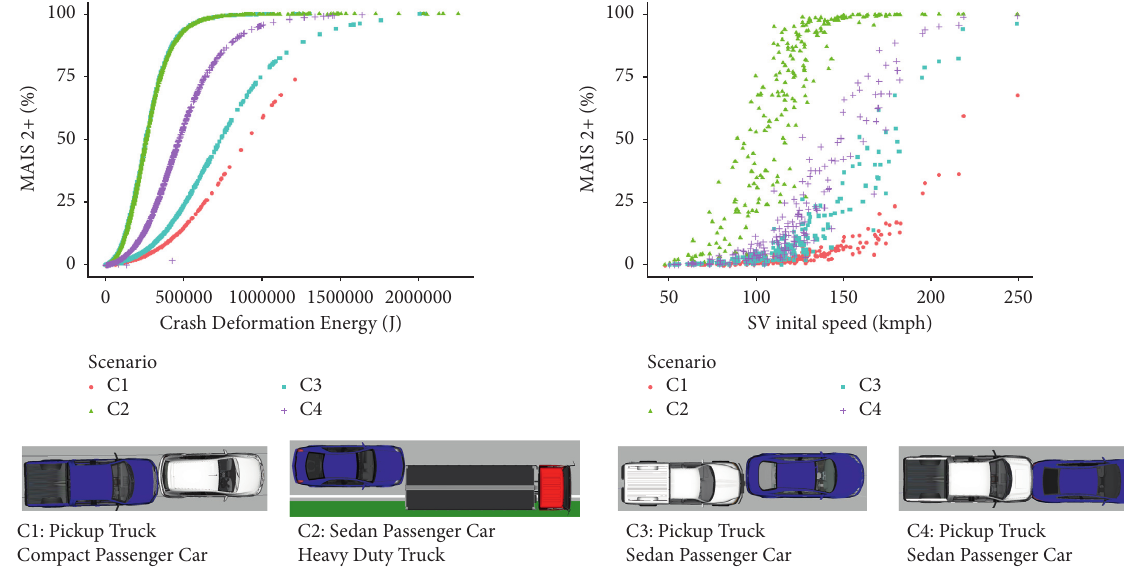
Figure 14: The risk of injury based on the crash deformation energy and speed for each crash scenario.